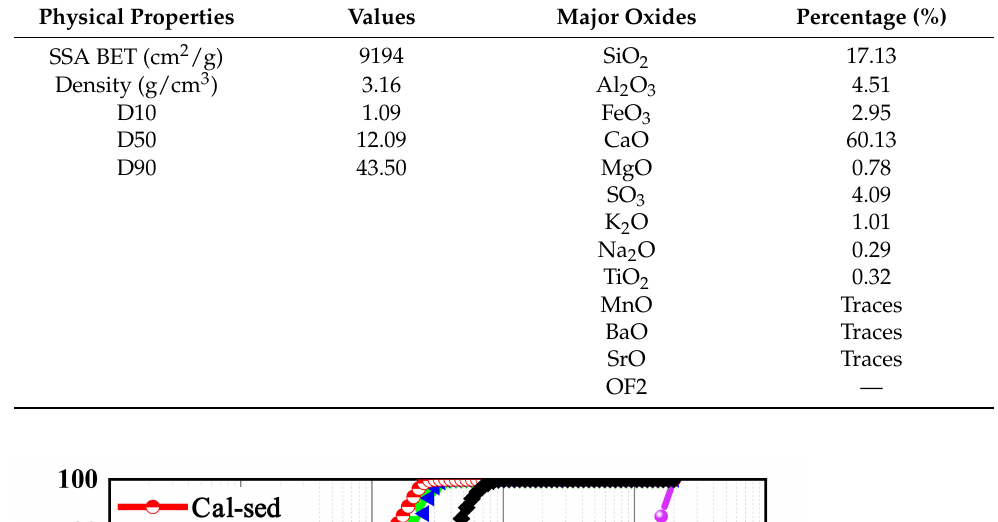
Table 1. CEM I 42.5 N physical and chemical properties.